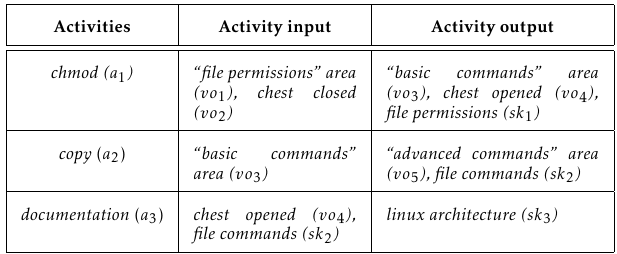
Table 2. Description of activities in